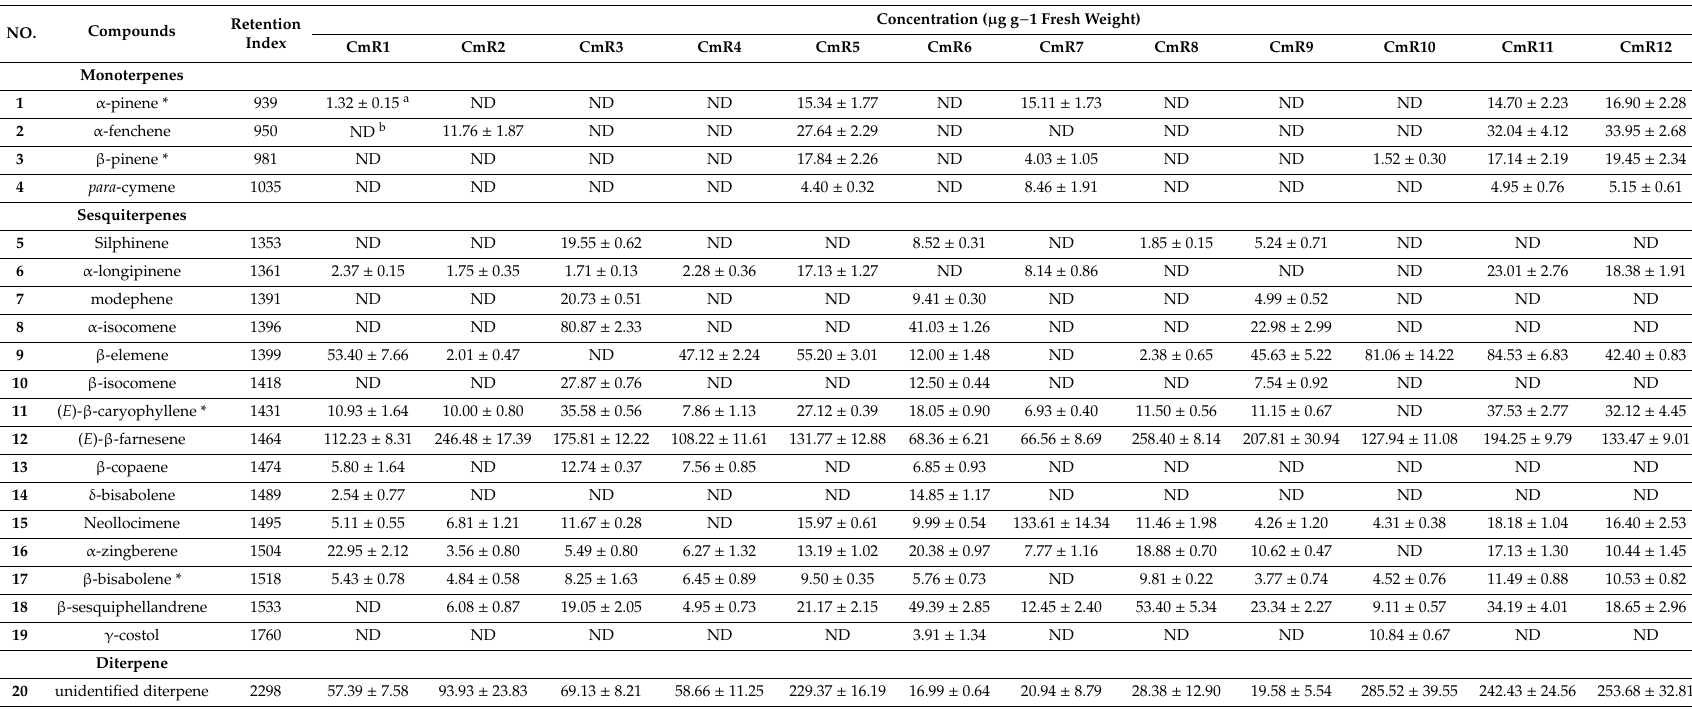
Table 2. Terpenoid constituents and concentrations (mean ± SD) from roots of 12 cultivars of C. morifolium